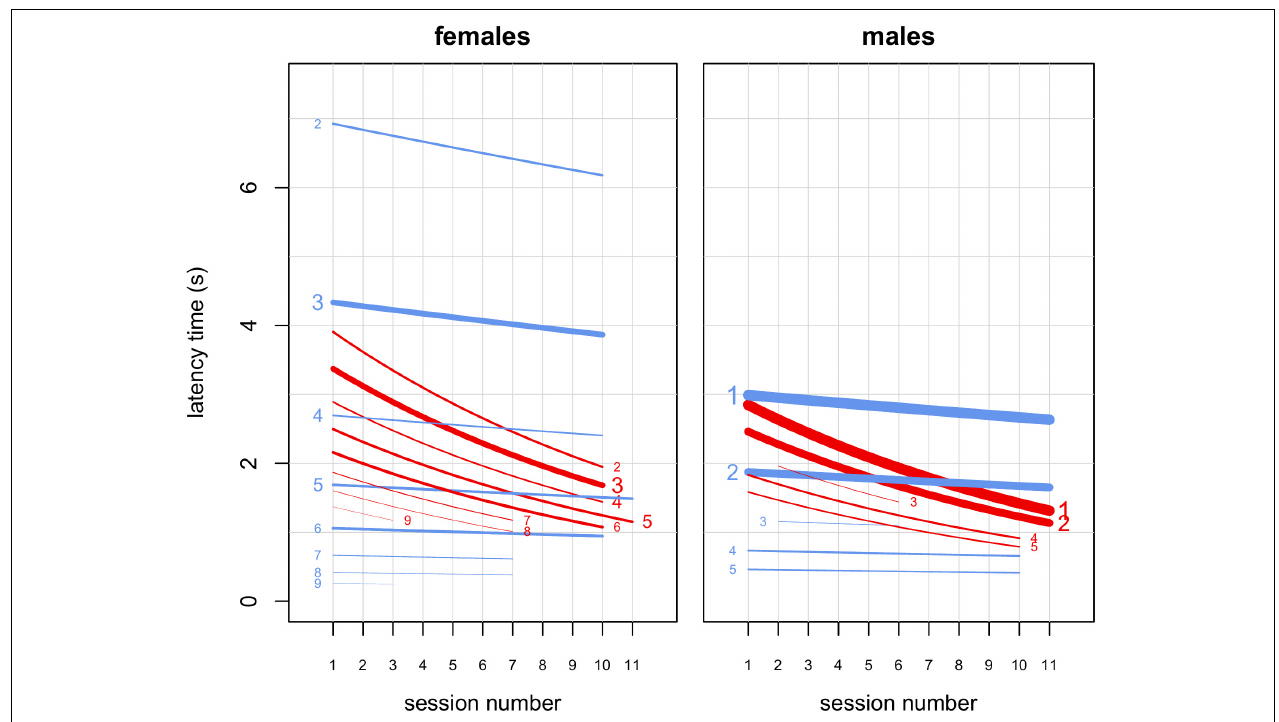
FIGURE 4 | Results from model M4. Interactions of sex, rank and session number with food type (familiar or novel). Lines represent estimated latency times as a function of session number for novel (red) and familiar (blue) foods and different ranks, indicated by numbers on the right (for novel) or left (for familiar) of each line. The plot on the left concerns females, while the plot on the right concerns males. All other predictors were kept at their sample mean. Line width is proportional to the number of observations for each combination of food type, rank and sex. Lines extend from the minimum to the maximum session number for each combination of food type, rank and sex. Font size of numbers indicating rank is proportional to the number of subjects in each rank in the study sample. Latency time is generally shorter for low-ranking individuals and latency time for novel food decreases markedly from early to late